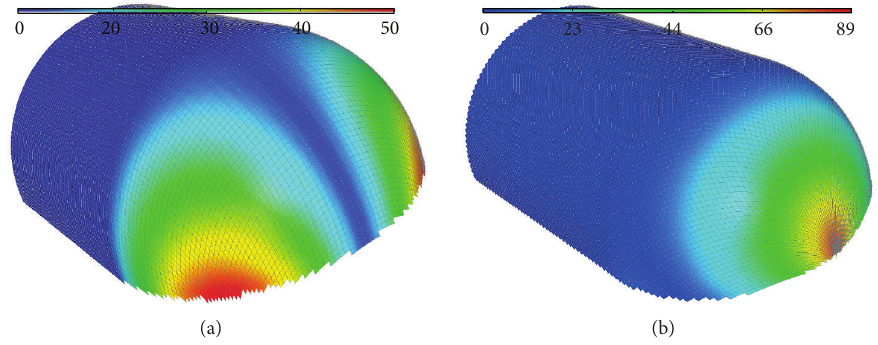
F 7: Optimal 3D surface layup: (a)